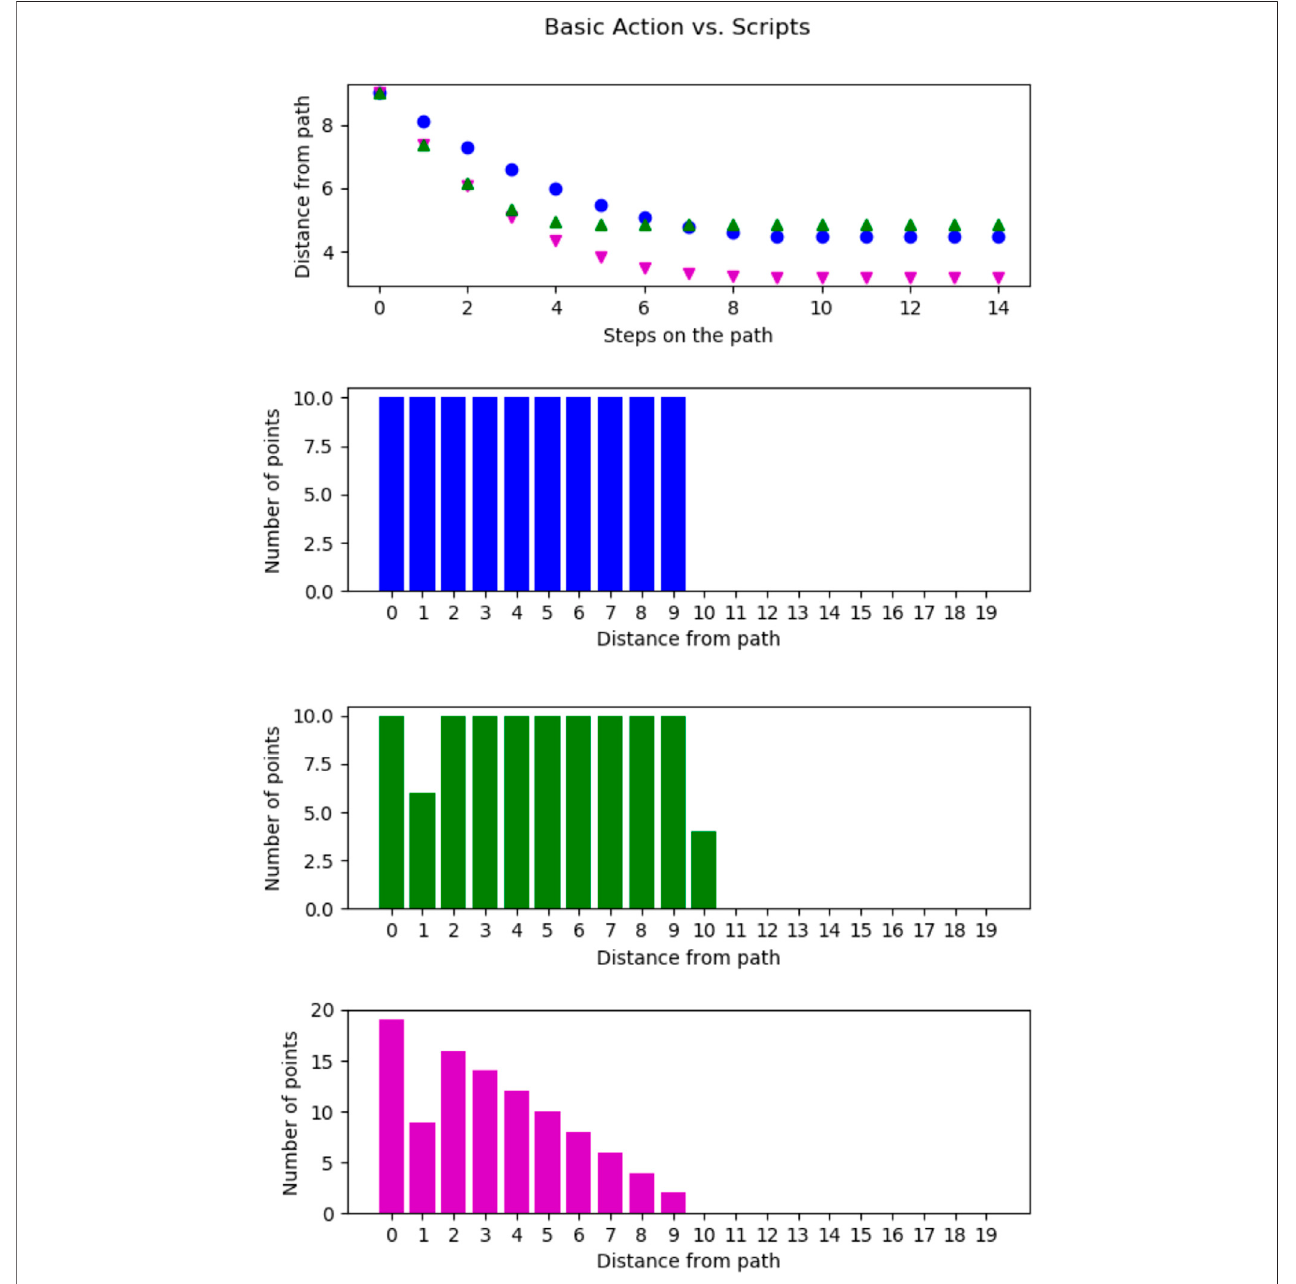
(cid:129) FIGURE5| Comparisonofthesingleactiontrajectoryofthebasicaction( west )inblue( ),thescript( west,west )ingreen( ▲ )andthescript( west,north )inmagenta ( ▼ ) fromthesoutheastcorner ofthe world.Top, theaveragedistance( V g )ofthepossible goalstates, (e.g allstates) per stepon thetrajectory. Second, number ofstates with a given distance V g from the agents movements for the basic action ( west ). Third, number of goals with a given distance V g from agents movement for the script ( west, west ). Fourth, number of goals with a given distance V g from agents movement for the script ( west, north ).